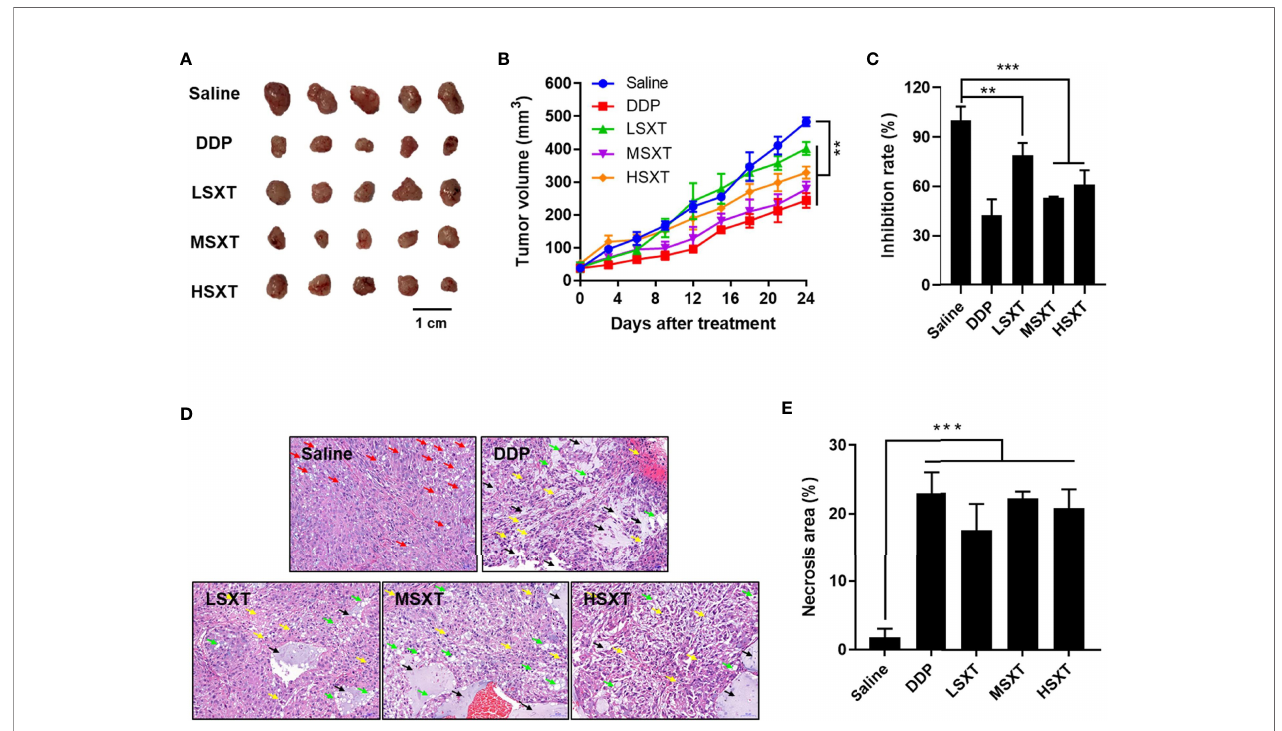
FIGURE 4 | In vivo anti-tumor effect of SXT. (A) Image of tumors isolated from mice treated with 0.9% saline (vehicle control), 22.36 mg/kg/d of cisplatin (DDP, positive control) and 9.55 g/kg/d (LSXT), 28.65 g/kg/d (MSXT) and 38.20 g/kg/d (HSXT) of SXT extract after 24 days of treatment. (B) Tumor volumes in different groups of mice during treatment (measured at Day 0, 4, 8, 12, 24) (mean ± S.D., n = 5), **P < 0.01 (two-way ANOVA test). Subcutaneous injection of A549 cells in SXT -treated nude mice showed low tumor forming capacity as compared to that treated with the saline control. (C) Inhibition rate of A549 xenograft (in weight) in mice with different treatments at the endof experiment (mean ± S.D.,n = 5), **P < 0.01, ***P < 0.001 (one-way ANOVA test to saline). (D) Representative histological images tumor sectionsstained with haematoxylin and eosin showing the induction of damages andnecrosisafter SXTtreatment at differentconcentrations. Objective magni fi cation: